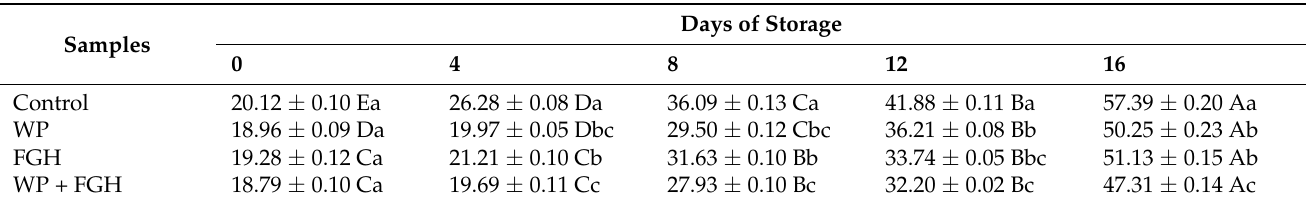
Table 1. Cooking loss (%) of chicken breasts fillets coated with whey protein (WP), fish gelatin hydrolysates (FGH), or combination of both (WP + FGH) during prolonged cold storage at 4 ◦